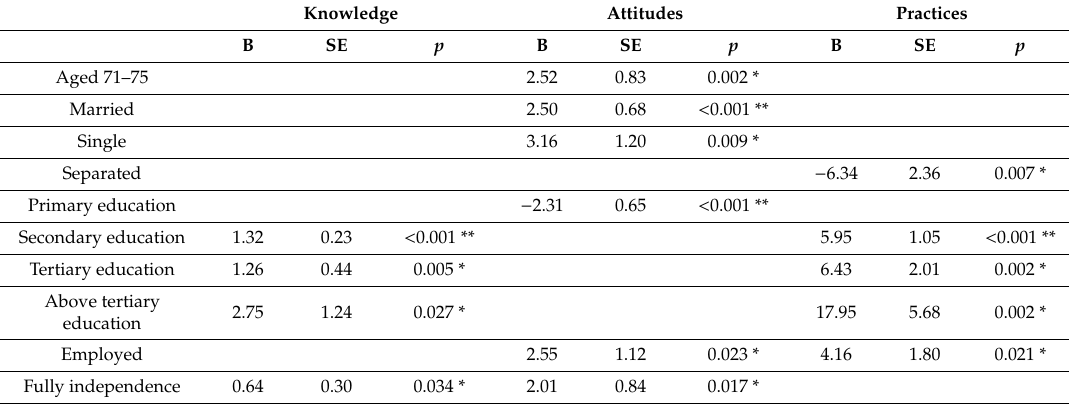
Table 4. Results of multivariate regression for factors associated with KAP related to oral care among elderly people (n =